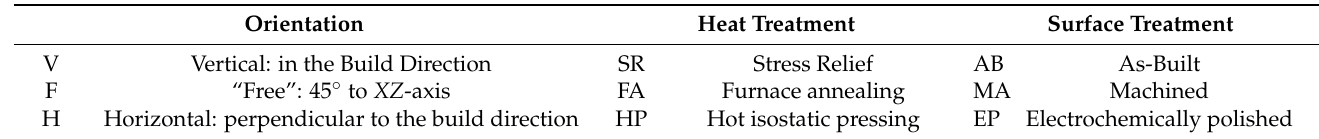
Table 2. Specimen